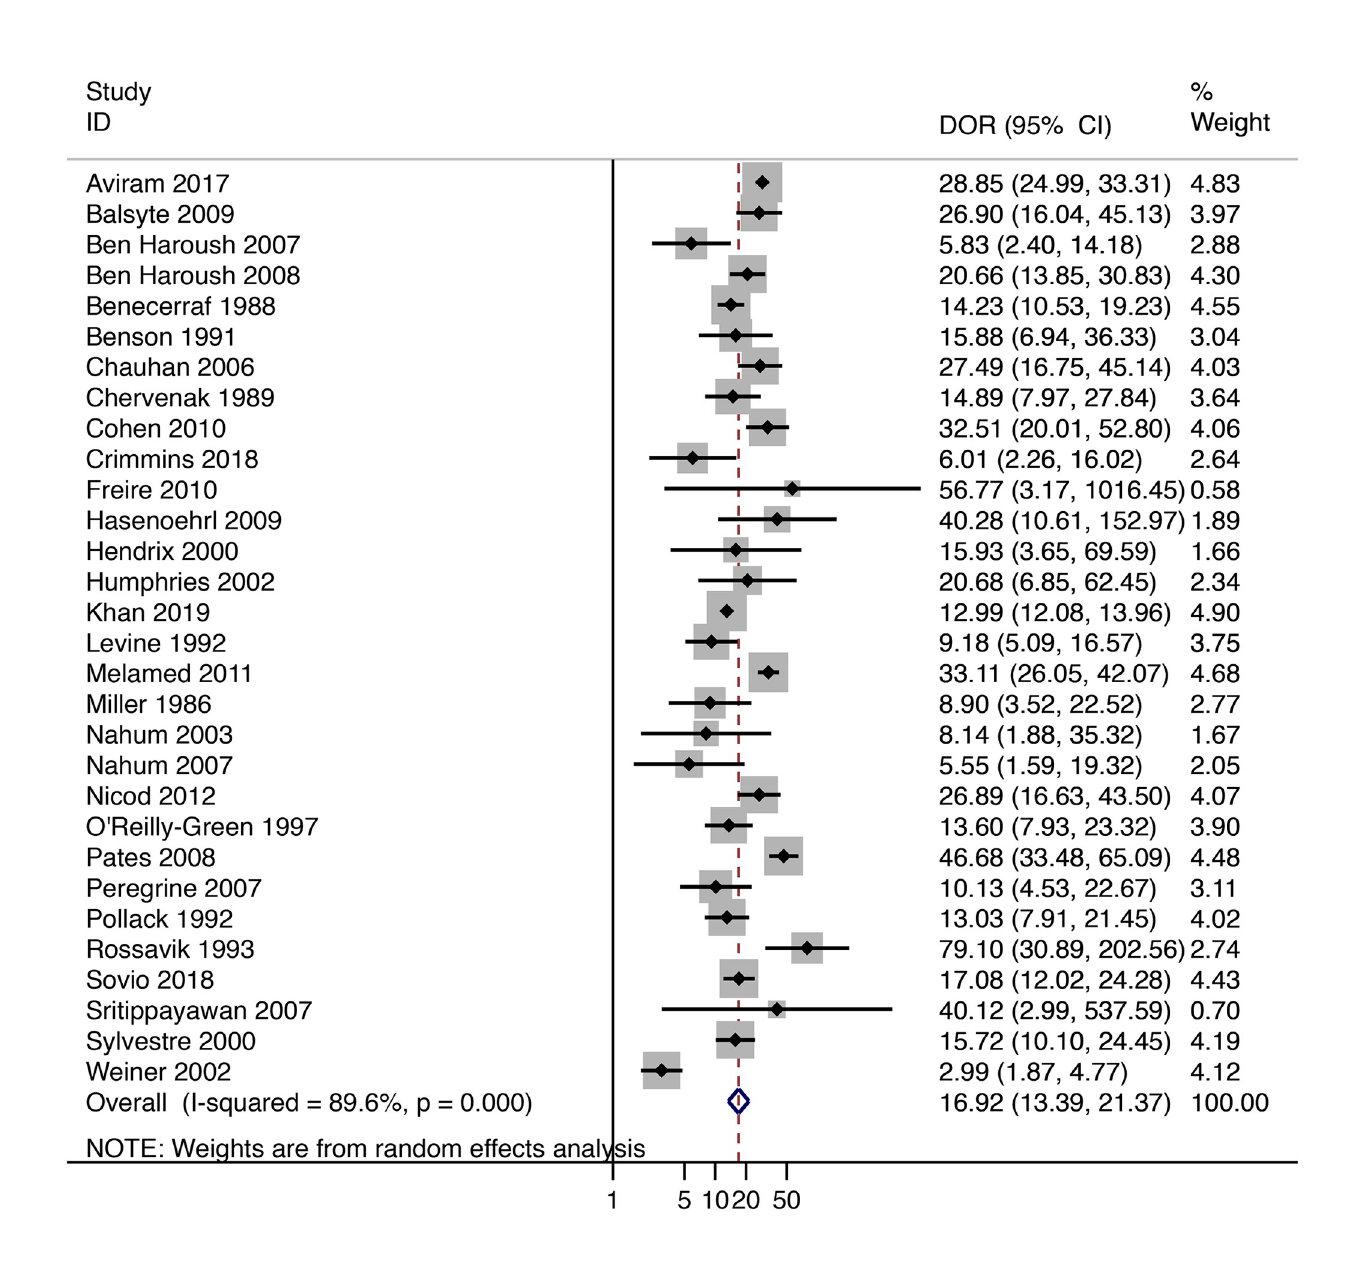
Fig 4. Diagnostic performance of EFW > 4,000 g (or 90th centile) at predicting macrosomia at birth (birthweight above 4,000 g or above the 90th centile). EFW, estimated fetal weight.